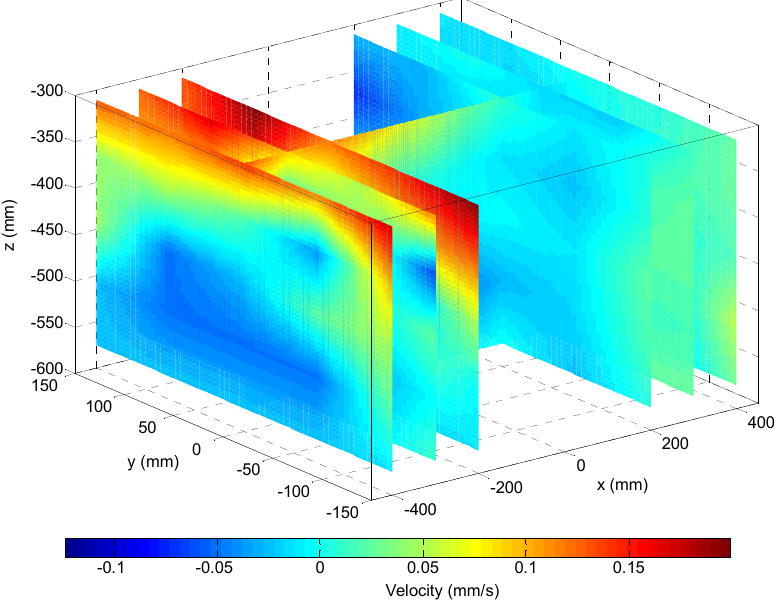
Figure 12. Four-dimensional graph of the evolution of the water speed along the water channel while running the optimal propulsion